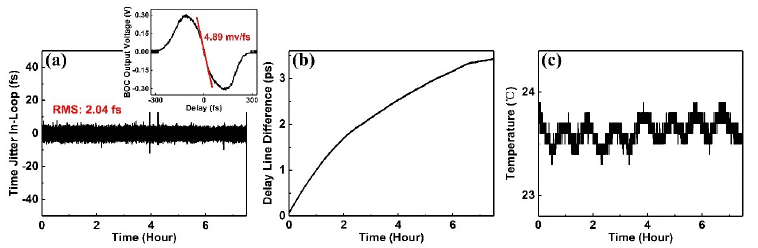
Figure 2. Timing fluctuation correction without optical path length correction: ( a ) timing jitter between the oscillator and the regenerative amplifier with the feedback loop closed (the insert shows optical cross-correlation traces); ( b ) variation of the delay line in the feedback loop; ( c ) temperature fluctuations in the environment.